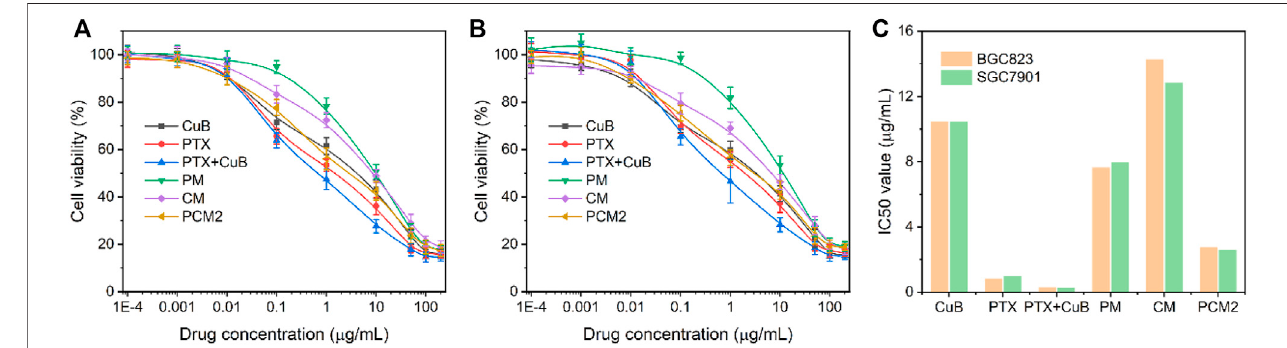
FIGURE6| In vivo antitumor effects. (A) Changes intumor volume during thetreatmentcycle. (B) Dissected tumor weightat day 21indifferent groups. (C) TSRof PTX, CuB, PTX+CuB, PM, CM, and PCM2. (D) Changes in body weight during the treatment cycle. Data are exhibited as the mean ± SD, n = 5.